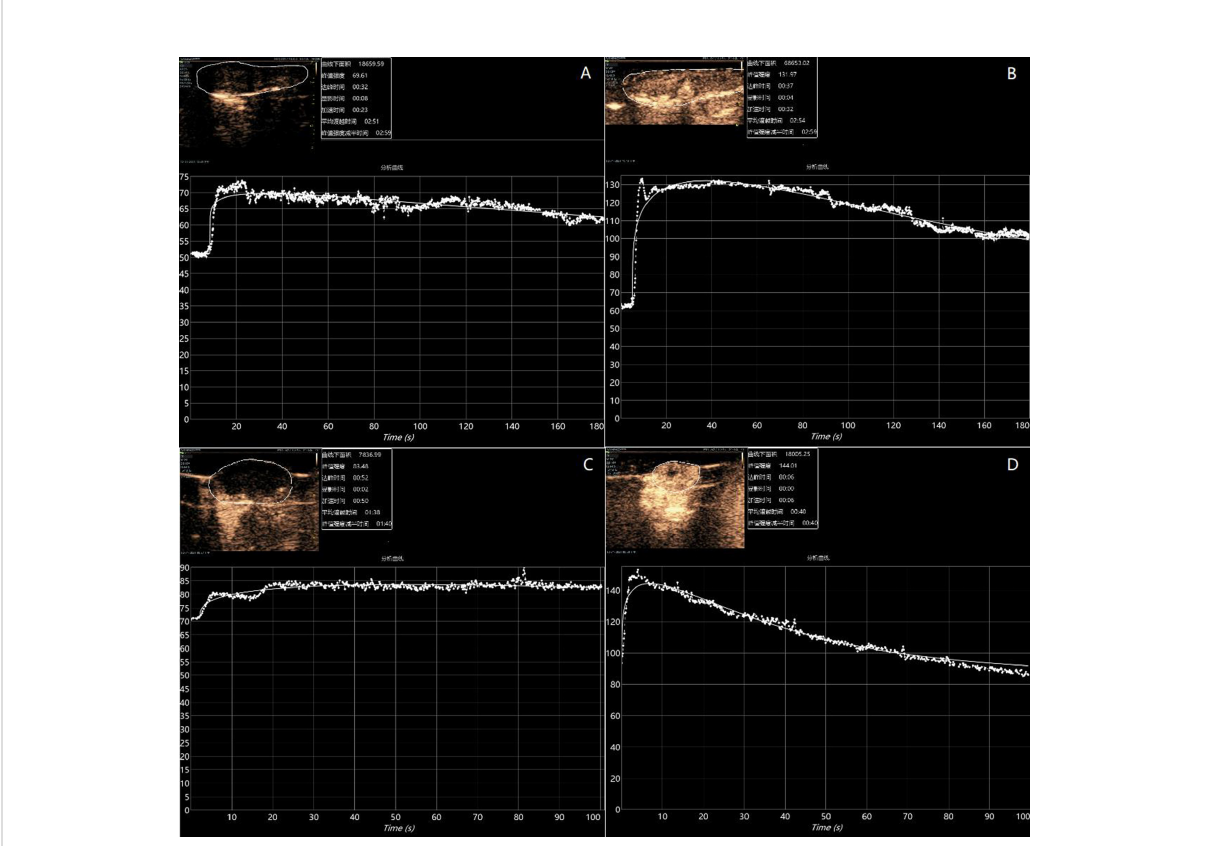
FIGURE 7 Preparation-based imaging of the liver (A) and tumor (C) of mice with poorly imaged contrast agents (Pk1: 185.1 nm, PDI: 0.22, and intensity: 181.2 nm). Preparation-based imaging of the liver (B) and tumor (D) of mice with better imaged contrast agents (PK1: 200.4 nm, PDI: 0.41, and intensity: 496.2